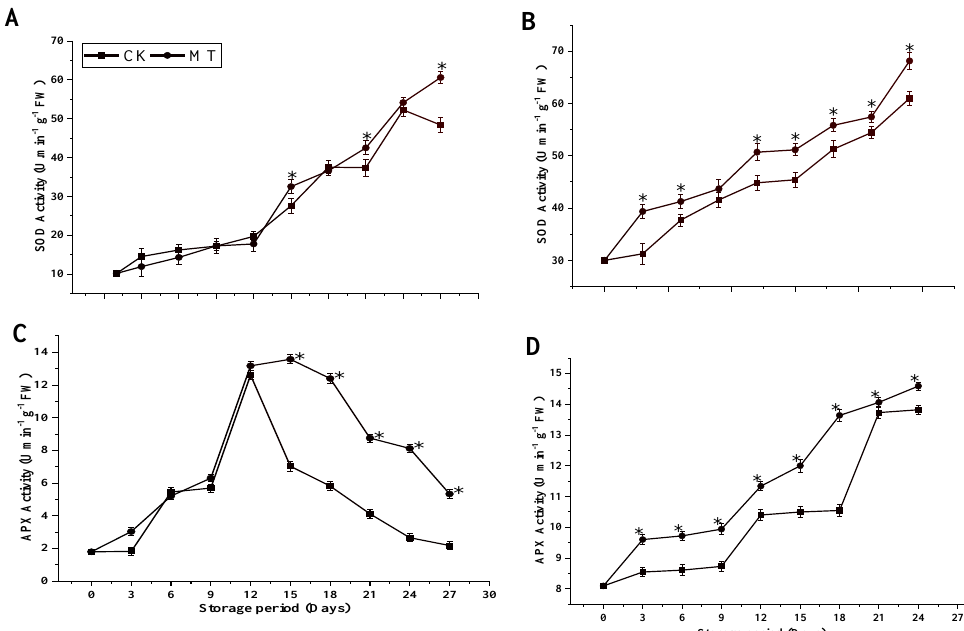
Figure 8. SOD activity ( A , B ) and APX activity ( C , D ) of ‘Guiqi’ ( A , C ) and ‘Tainong 1 ’ ( B , D ) fruits treated with 1000 μmol L −1 MT. Each value is the mean for three replicates, and vertical bars indicate the standard error (SE). Error bars with an asterisk (*) on the same storage period show a significant difference between the treatments ( p < 0.05).